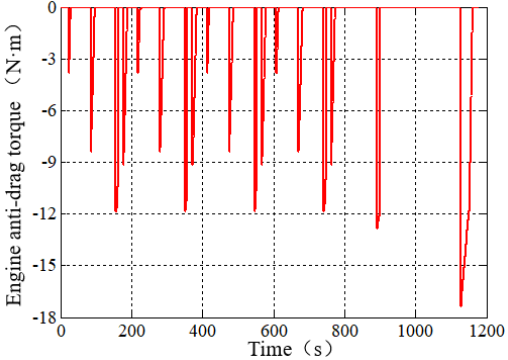
Figure 14. Engine anti-drag torque in the NEDC condition.